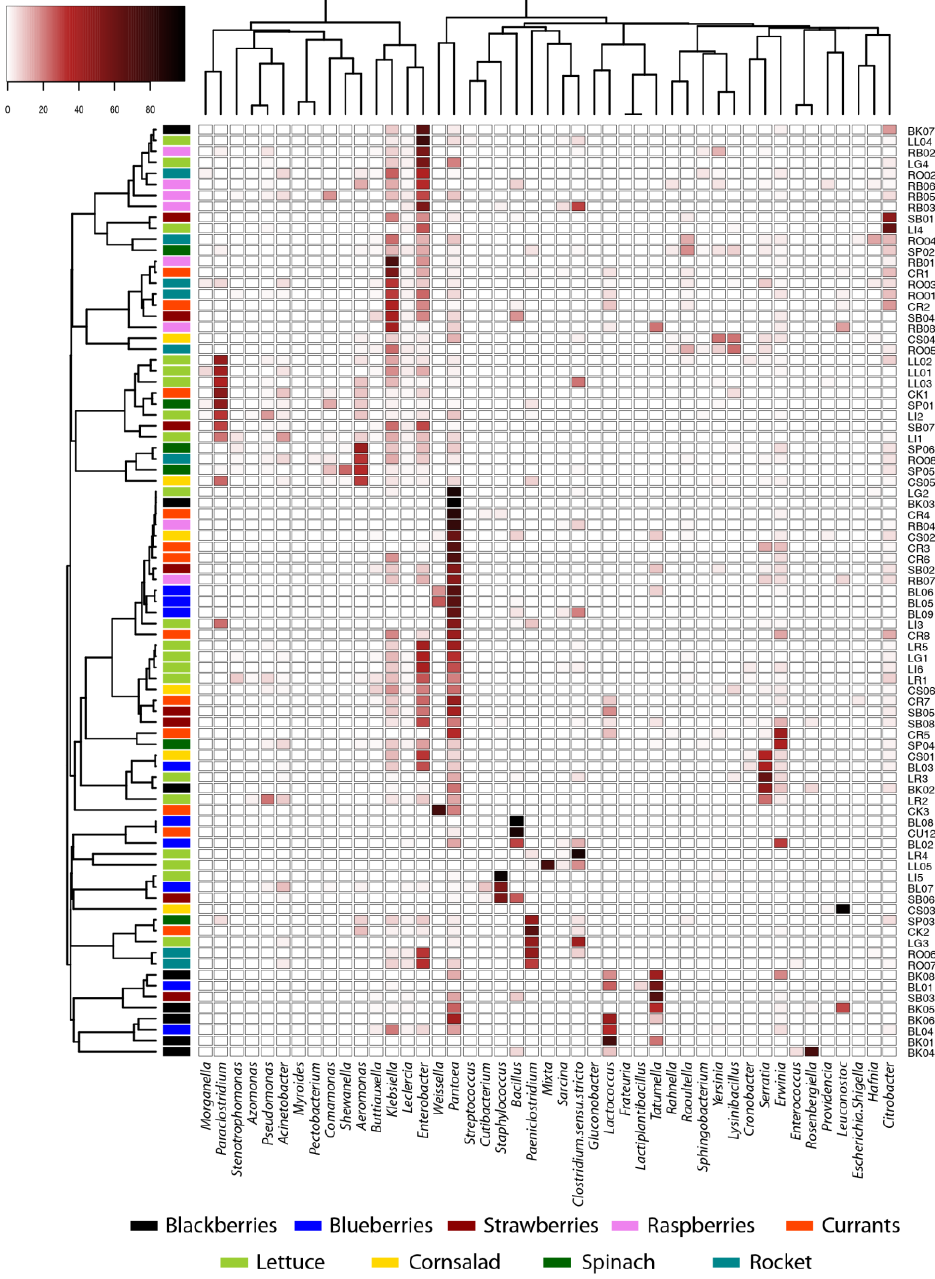
Figure 4. Heatmap of bacterial genera composition according to analysis of DNA extracted samples of leafy vegetables and berry fruits pre-enriched in peptone buffered water. Only genera with min. 2% occurrences in any samples are listed. Dendrograms are based on occurrence of genera in samples (Bray-Curtis distance, complete clustering).